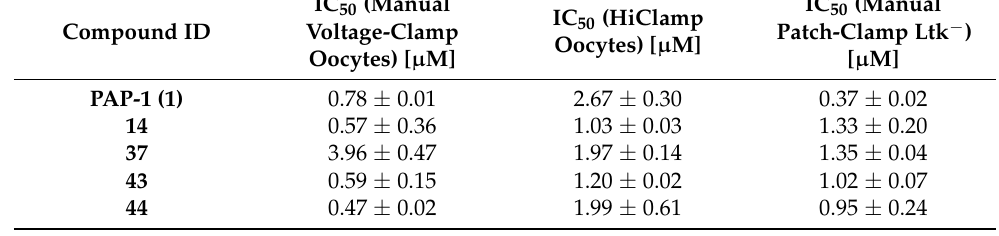
Table 3. Comparison of Kv1.3 IC 50 values for compounds 14 , 37 , 43 , 44 , and PAP-1 ( 1 ) obtained with HiClamp and manual voltage-clamp on Xenopus laevis oocytes (Tables 1 and 2) and with manual patch-clamp on the Ltk − cell-line.